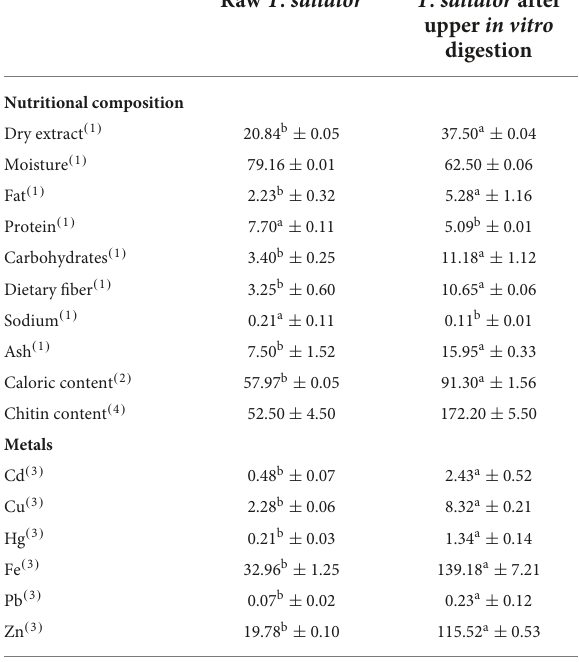
TABLE 1 Nutritional composition and mineral content of Talitrus saltator, raw and after upper in vitro